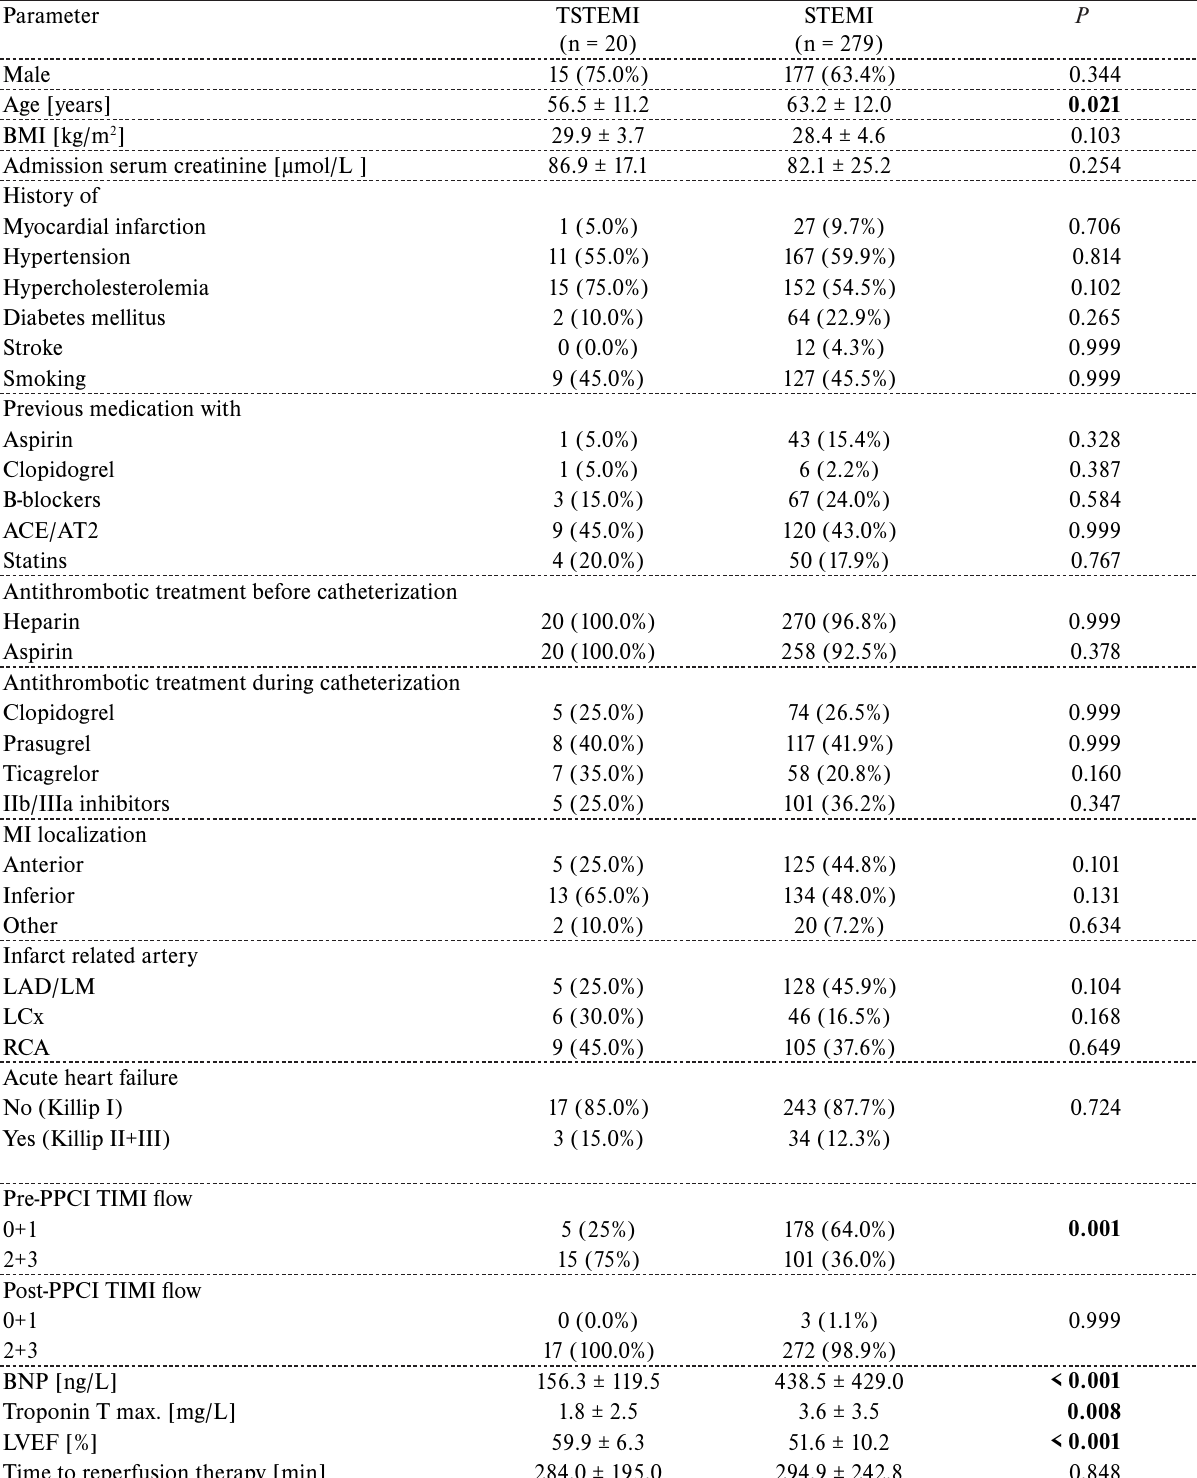
Table 1. Comparison of clinical characteristics of TSTEMI and STEMI